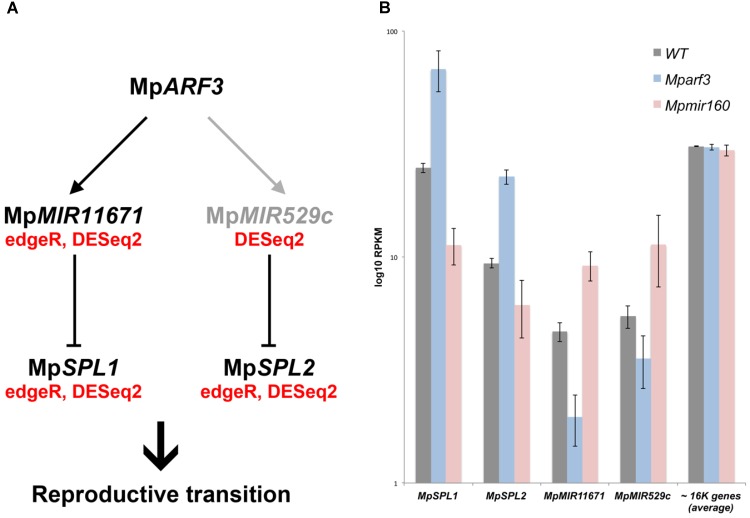
Model for MpARF3 dependent regulation of reproductive phase changes in M. polymorpha. (A) Putative regulatory relationships between MpARF3 and MpSPL1-2 as supported by RNA-Seq data. Relationships supported by two (edgeR and DESeq2) or one statistical analyses (DESeq2) are indicated. Reproductive phase change roles are attributed to M. polymorpha SPL genes given their common enrichment in gametangiophores. (B) Average log10RPKM values (biological triplicates) for MpSPL1, MpSPL2, MpMIR11671, and MpMIR529c in our experimental conditions. The average RPKM value for all mapped genes (N = 16520) per library is ∼30. Error bars show SD.